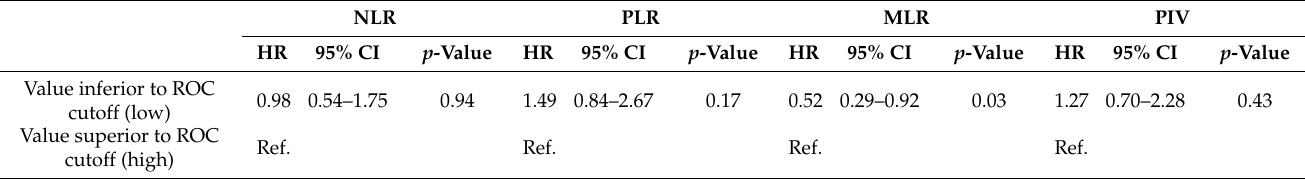
Table 3. Univariate analysis of the pre-treatment NLR, PLR, MLR, and PIV systemic inflammatory biomarkers predictive of 5-year